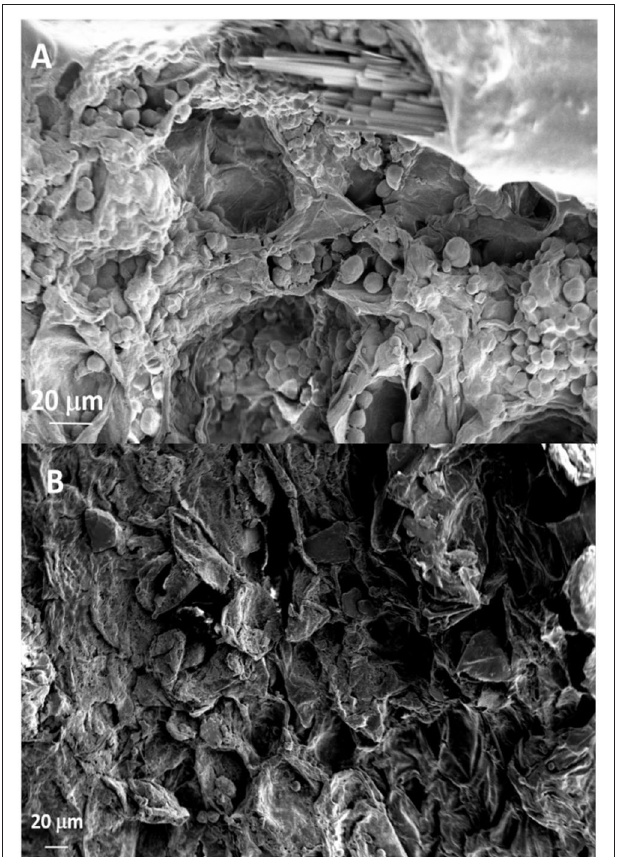
FIGURE 5 | SEM micrographs showing canals formed in phloem layers of KEDS symptomatic plants with raphides in the inner lumen without (A) or with mucilage (B) . Results of the EDS analysis of both raphides and mucilage are presented in (B) .